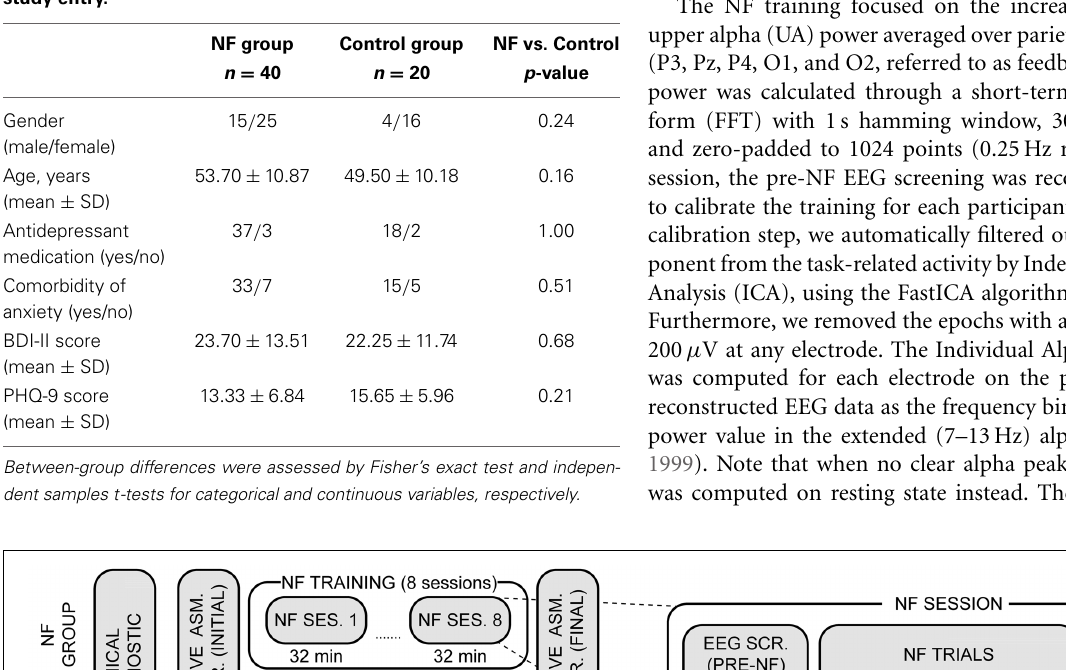
Table 1 | Demographic and clinical variables of the participants at study entry.